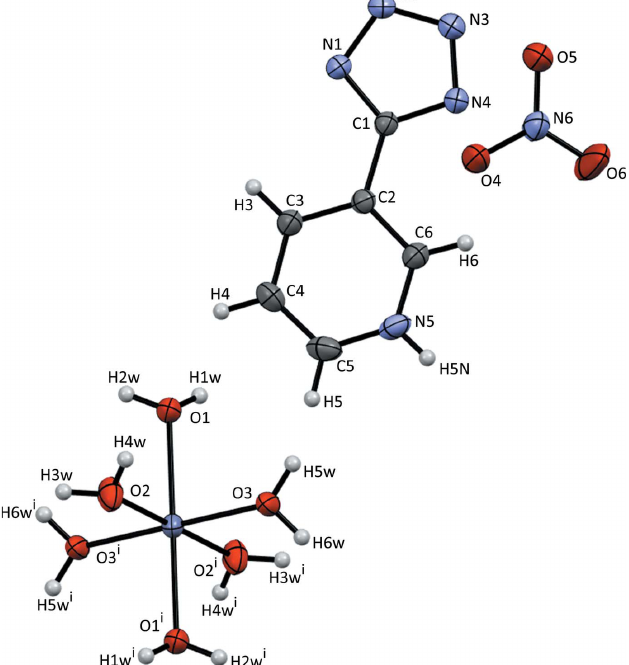
Figure 2 Partial crystal packing of the title compound, showing the hydrogen- bonding interactions between [Zn(H 2 O) 6 ] 2+ and the tetrazolide ring. [Symmetry codes: (ii) (cid:3) x + 1, (cid:3) y + 1, (cid:3) z + 1; (iii) (cid:3) x + 1, (cid:3) y + 2, (cid:3) z + 1; (x) x , y (cid:3) 1, z (cid:3) 1; (xi) x + 1, y , z (cid:3)